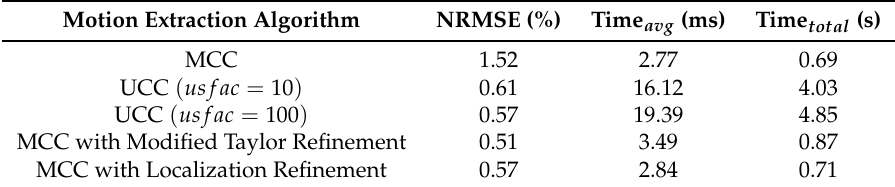
Table 1. Error and time consumption comparisons in the simulation test.